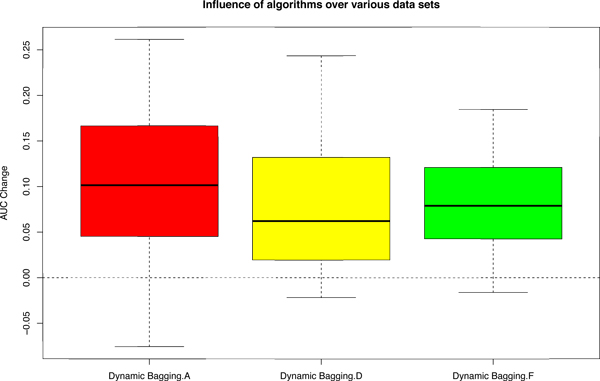
Boxplot of AUC change on different data sets (A, D, F) under various scenarios (36). AUC Change = AUCafter - AUCbefore. "Dynamic Bagging.A", "Dynamic Bagging.D" and "Dynamic Bagging.F" are the AUC change after applying dynamic bagging and using rank values on data sets A, D and F respectively compared with the conventional approach, which is without bagging and using absolute values [9].